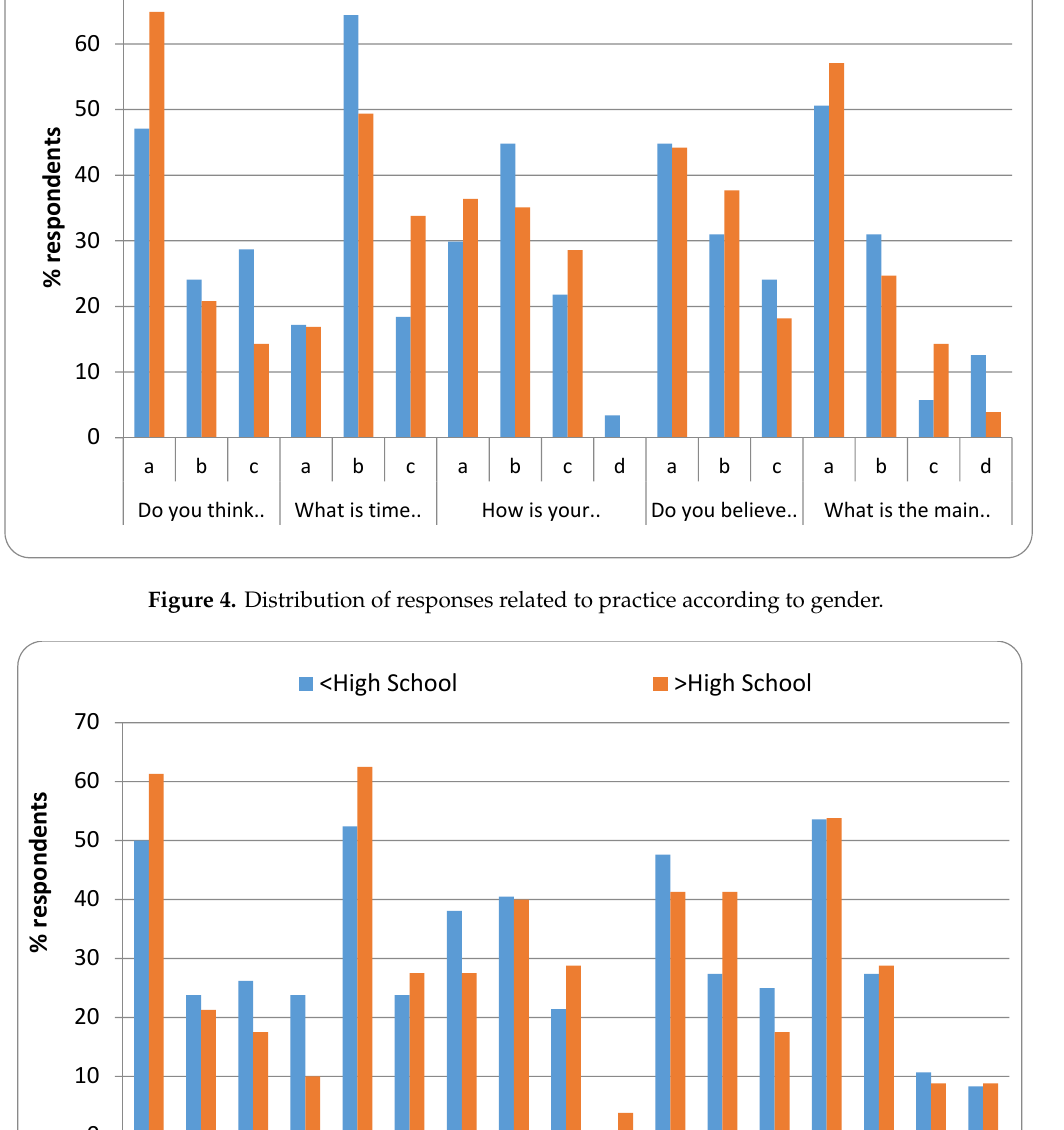
Figure 3. Distribution of responses related to the practice according to age group.